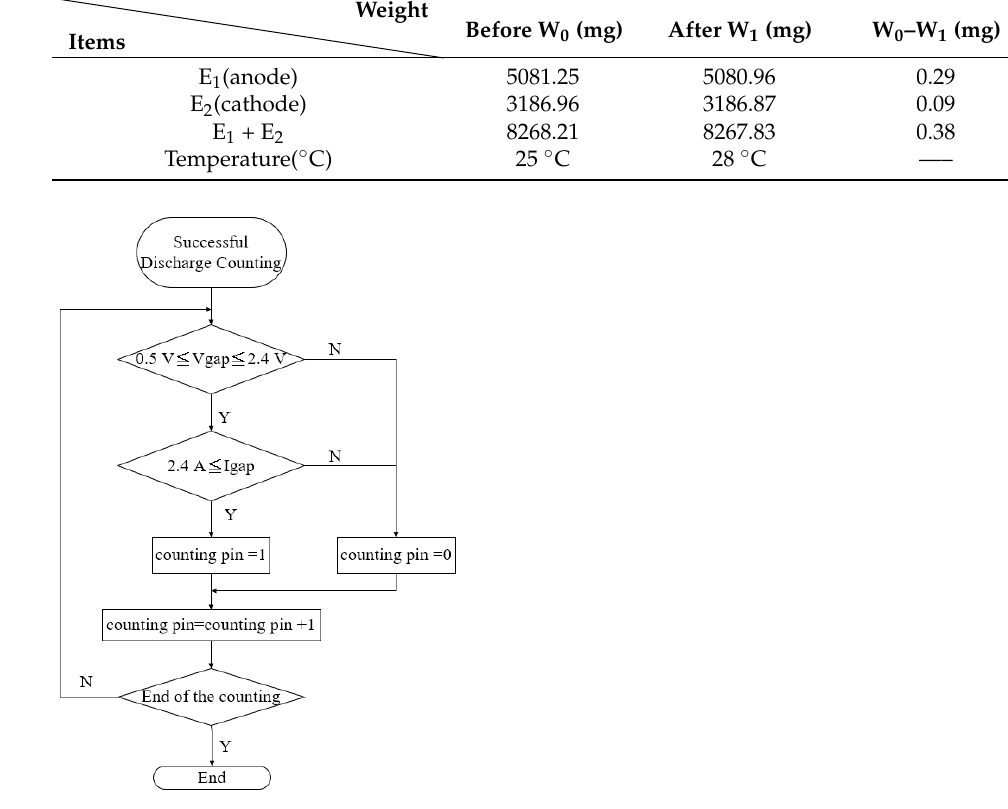
Figure 6. Flow chart of discharge success rate counting.